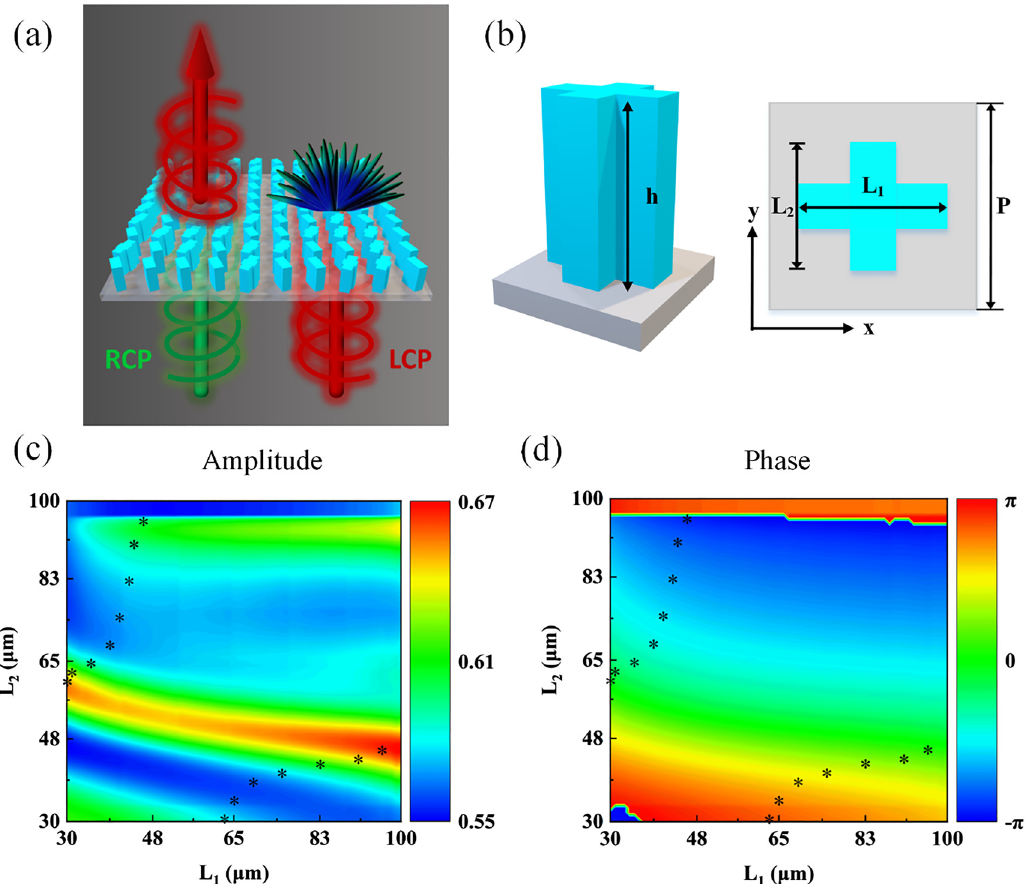
Figure 1: Characterization of the designed meta-atoms for spin-decoupling. (a) Schematic of the concept of the function similar to chirality. (b) Schematic of the orthogonal silicon pillars. (c) and (d) Simulated transmission amplitudes and phase shifts along x -axis as a function of the lengths of two pillars L 1 and L 2 under x -polarized illumination at 1.3